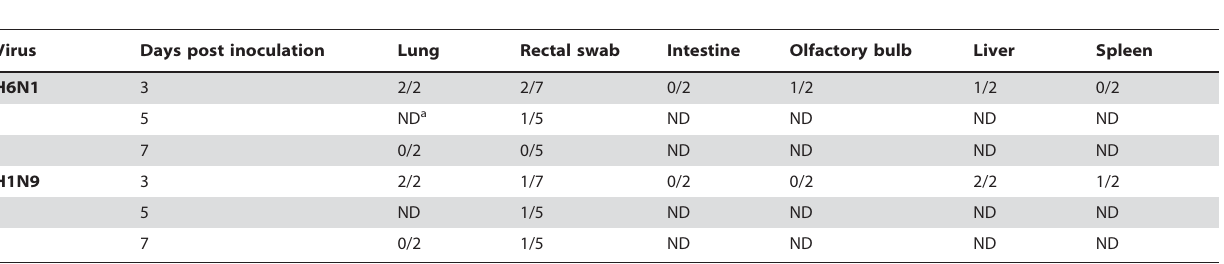
Table 2. Presence of influenza virus in ferret organs by virus isolation in ECEs for ferrets infected with wild bird avian influenza viruses H6N1 and H1N9.